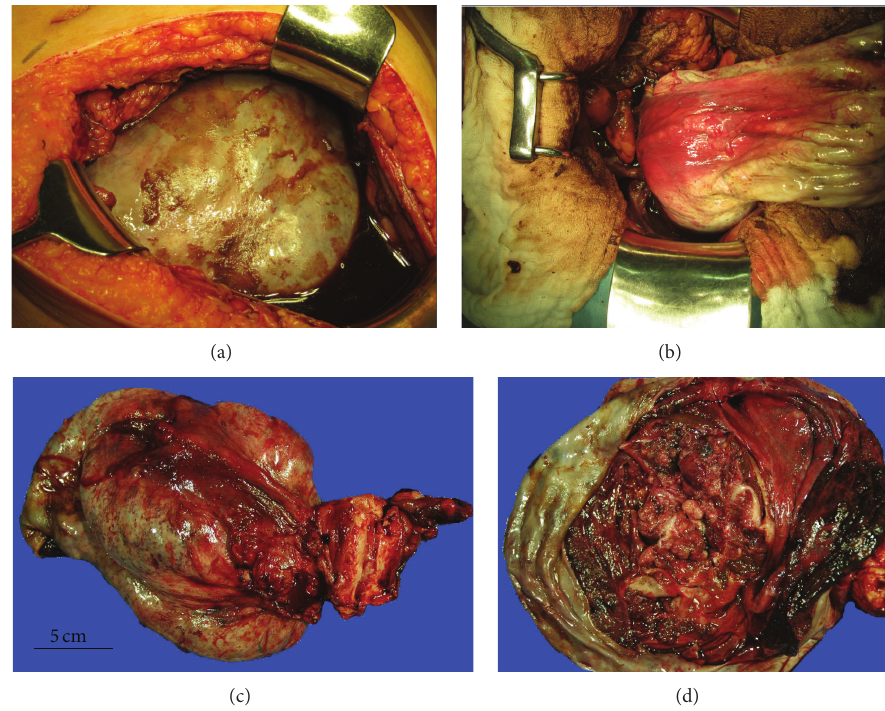
Figure 2: Operative findings. (a) The right ovary is markedly enlarged and contains a carcinoma. (b) The large ovarian tumor is removed via a vertical midline incision after abdominal drainage is performed. (c) The excised tumor mass is 20 cm in diameter. The uterus and left ovary are macroscopically normal. (d) The tumor mass contains septations and papillary solid lesions.